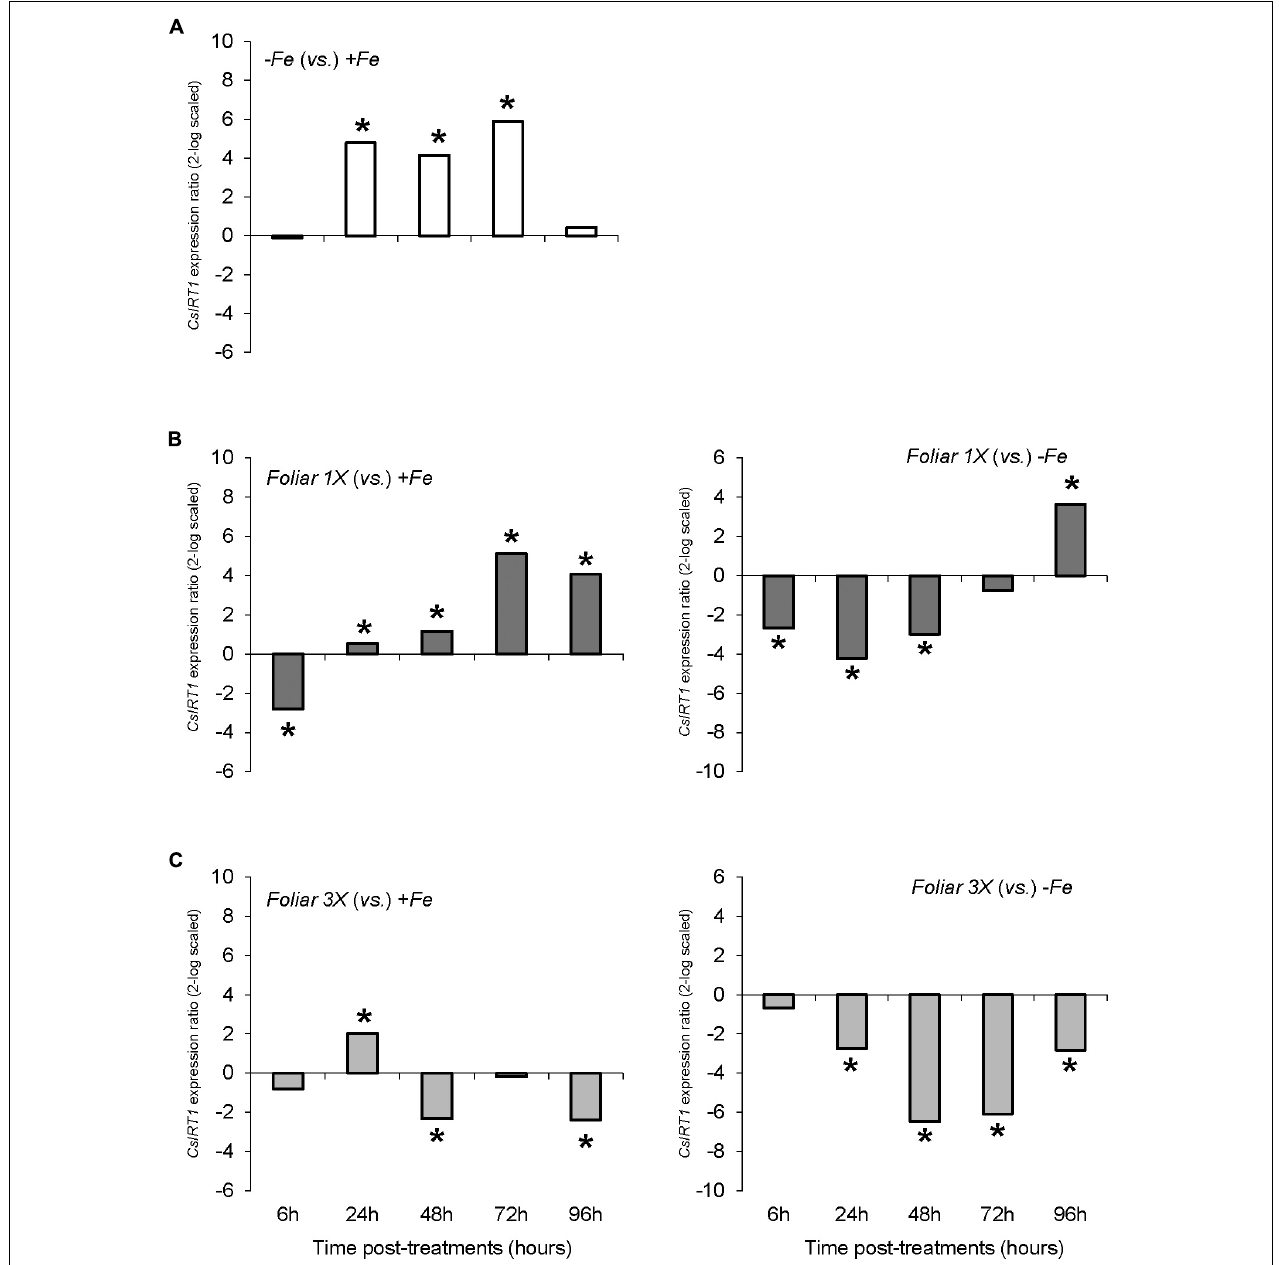
FIGURE 4 | CsIRT1 expression results in cucumber roots from Experiment I. Plants were grown in a nutrient solution with 5 µ M Fe, and then some of them were transferred to nutrient solutions with 40 µ M Fe (+ Fe ). The rest were transferred to nutrient solutions without Fe (– Fe ). A third of the – Fe plants were sprayed with a single dose of 9 mM FeSO 4 (2.54 mg Fe/plant, Foliar 1X ), and other third was sprayed during 3 consecutive days with 3 mM FeSO 4 (each plant received a total amount of 2.54 mg Fe/plant, Foliar 3X ). (A) Expression of CsIRT1 in root of – Fe plants versus + Fe plants. (B) Expression of CsIRT1 in root of Foliar 1X plants versus + Fe (left) and – Fe (right) plants. (C) Expression of CsIRT1 in root of Foliar 3X plants versus + Fe (left) and – Fe (right) plants. Data are means ± SE ( n = 5). Asterisks indicate significant differences between treatments at P < 0.05 based on one-way ANOVA and Fisher’s post hoc test. Statistical analysis of relative gene expression results was assessed using P-pairwise fixed reallocation randomization